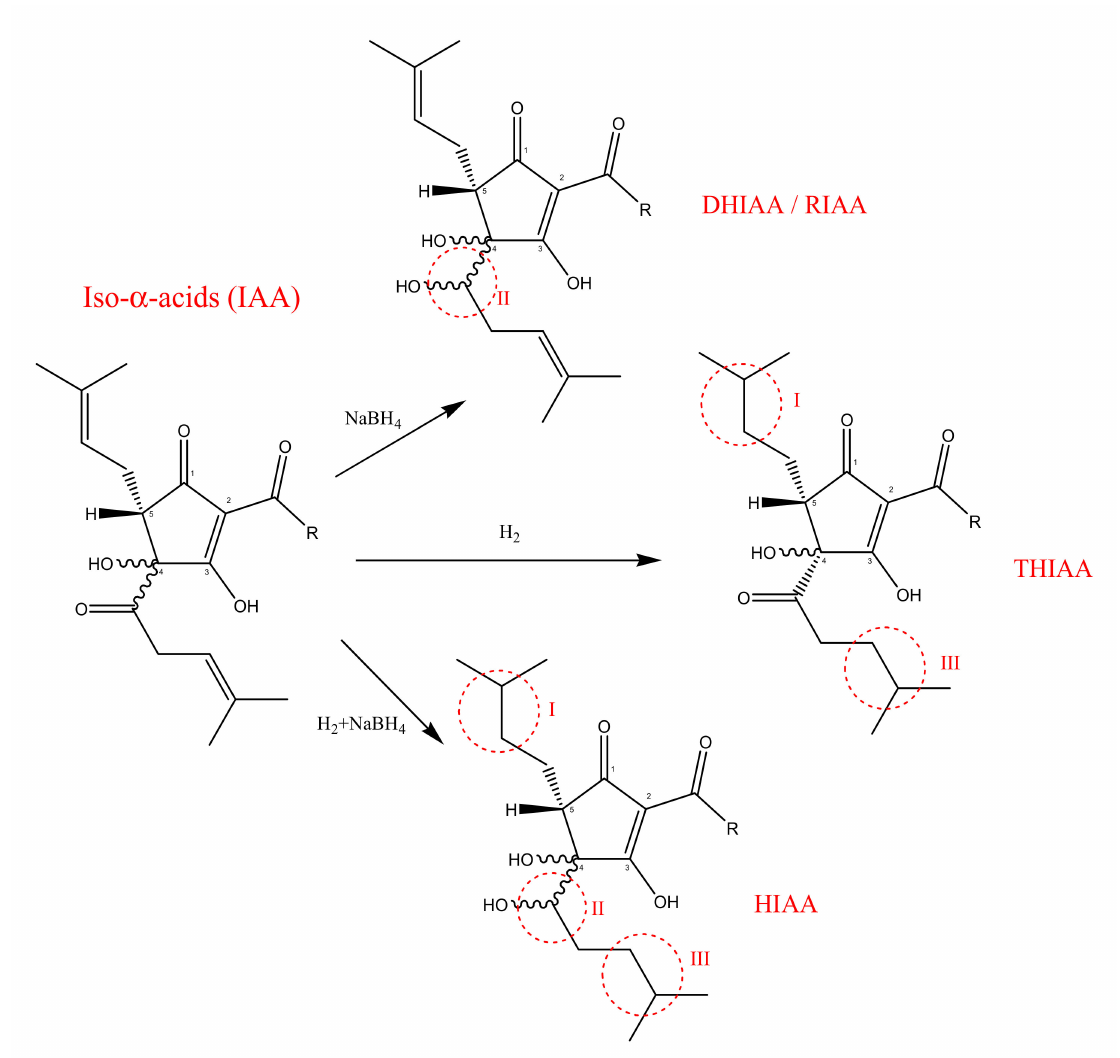
Figure 3. Reduction of iso - α -acids: I, III sites of increased hydrophobicity; II, III sites of photolytic cleavage